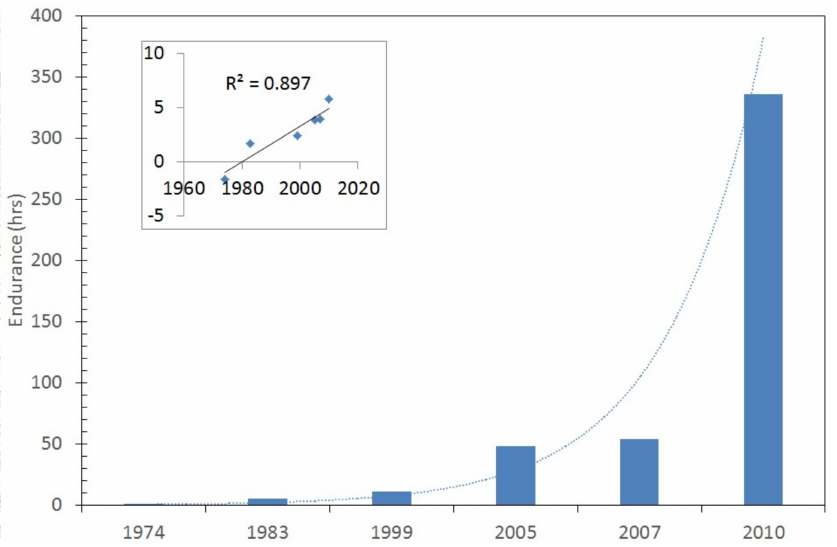
Figure 2. Endurance of solar aerial vehicles as developed over time. The overlaid exponential trend is statically significant at the 99.6% confidence level and is given in the